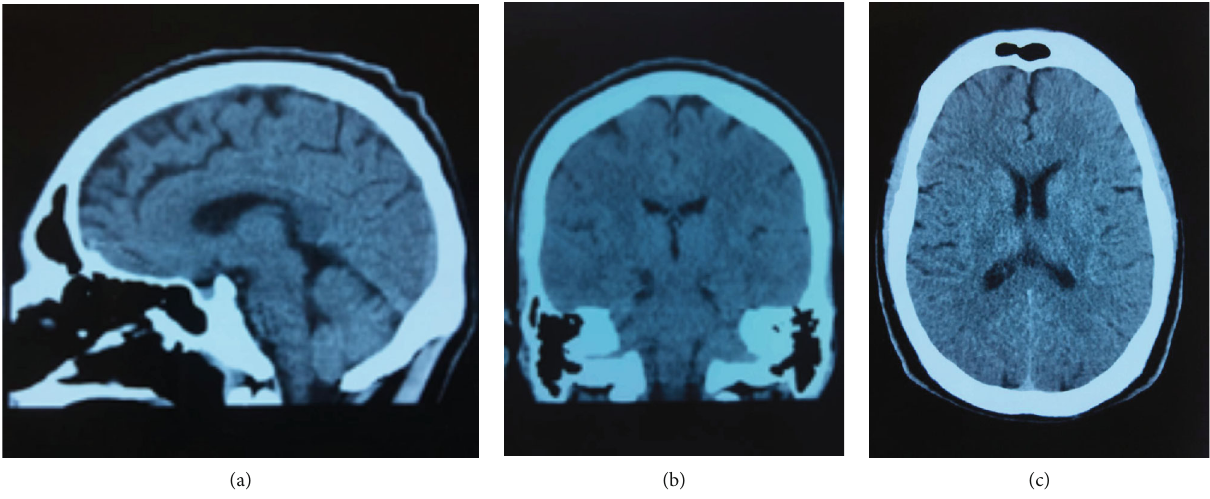
Figure 2: Noncontrast computed tomography of the